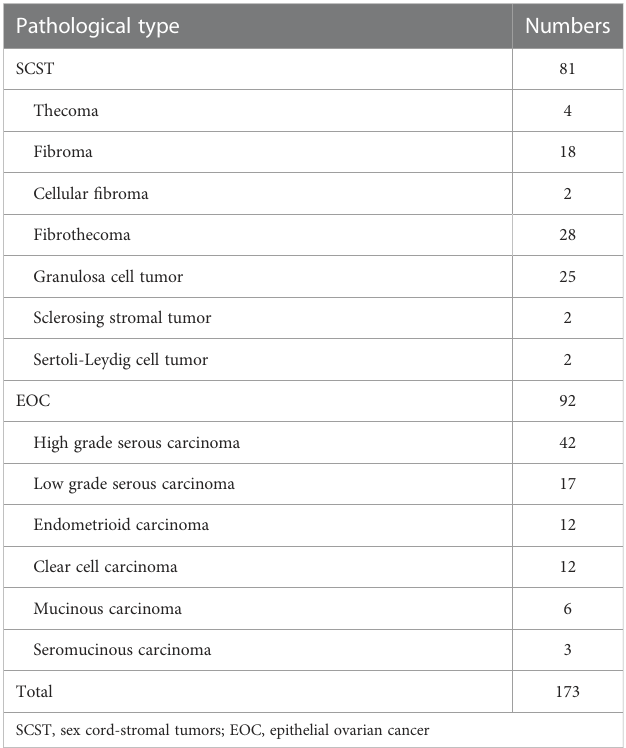
TABLE 1 Histopathological types of the selected